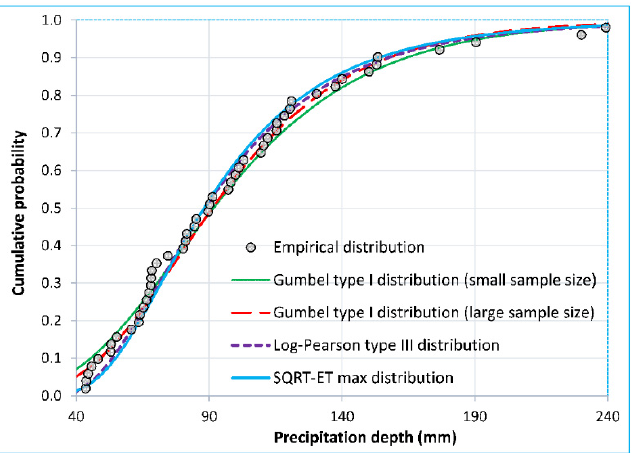
Figure 5. Cumulative probability against precipitation depth for the probability distribution functions.